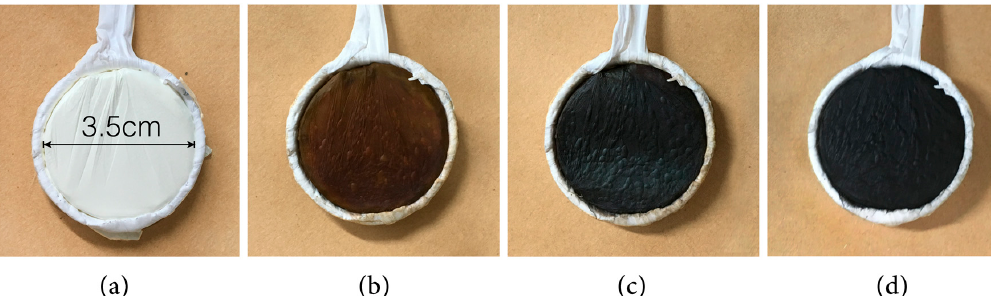
Figure 2. Change in the appearance of the nanofiber films during the metal loading process. ( a ) Untreated poly(amic acid) (PAA)/PEI film; ( b ) PAA/PEI film with AgNO 3 /dimethylamine borane (DMAB) ion exchanged once; ( c ) PAA/PEI film with AgNO 3 /DMAB ion exchanged 4 times; ( d ) metal displacement after 5 h.